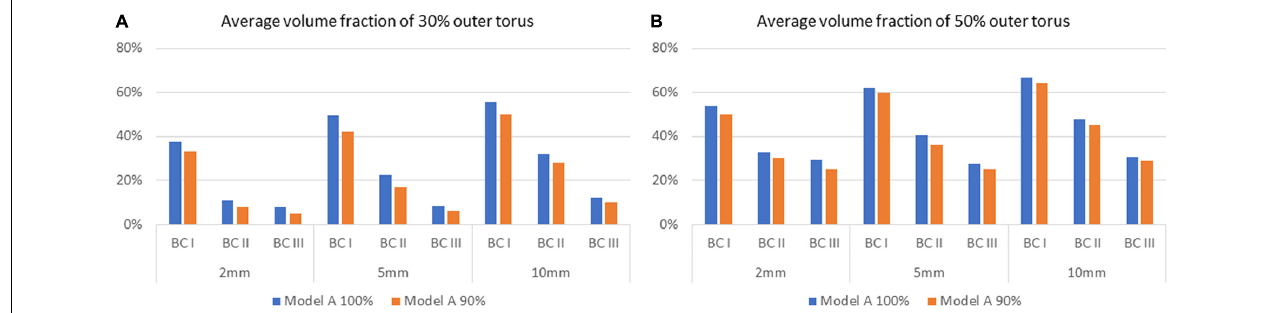
FIGURE 9 | Comparison of average volume fractions of flush flow for Model A between 100% and 90% delivery of the flush fluid, on the 30% and 50% outer torus on different cross-sectional planes, under three flowrates of the background blood flow. (A) Average volume fraction of 30% outer torus. (B) Average volume fraction of 50% outer